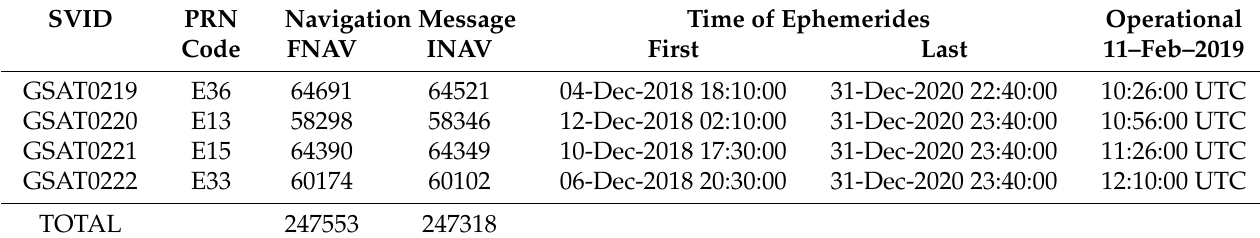
Table 1. Navigation messages transmitted by the Galileo L10 satellites over the study period. Each satellite has its unique space vehicle identification number (SVID). In addition, each satellite transmits a specific pseudo random number (PRN) code.